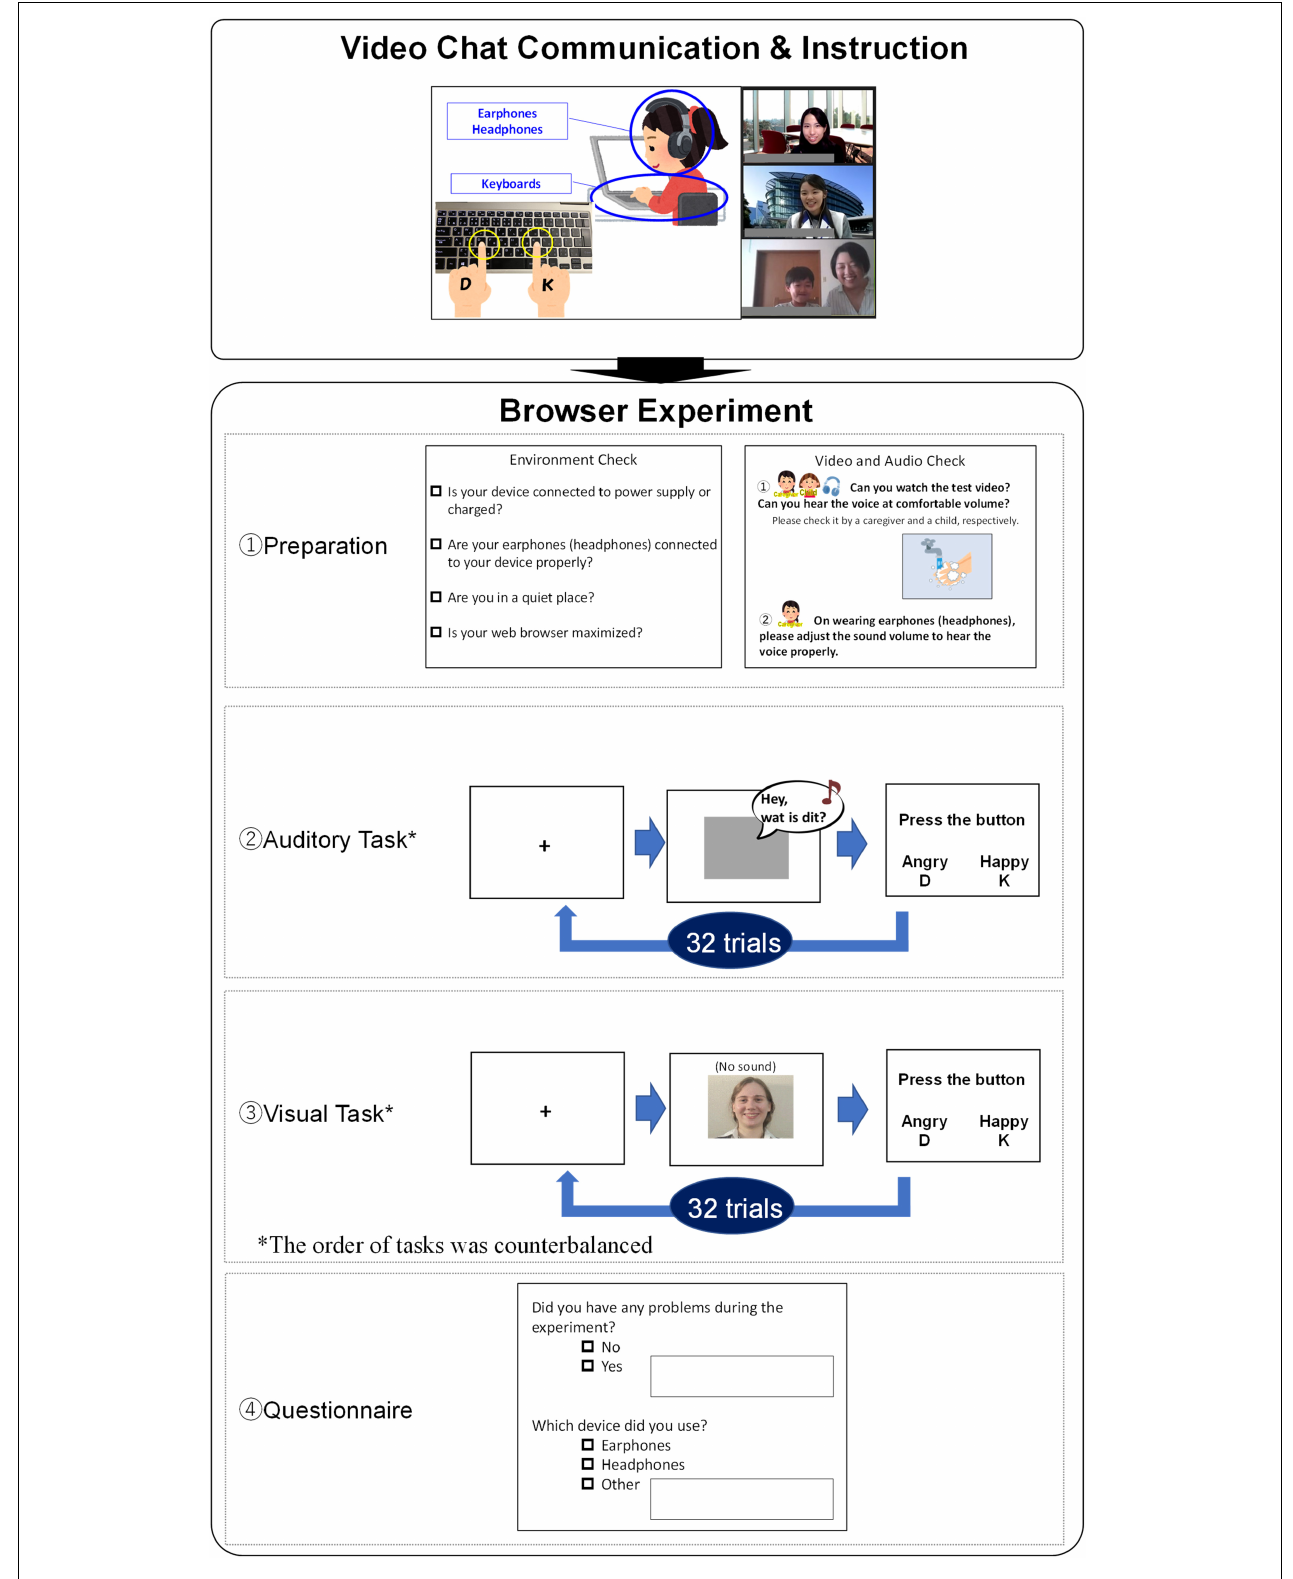
FIGURE 1 | Experiment flow (The instructions and alternatives were written in Japanese in the actual experiment).